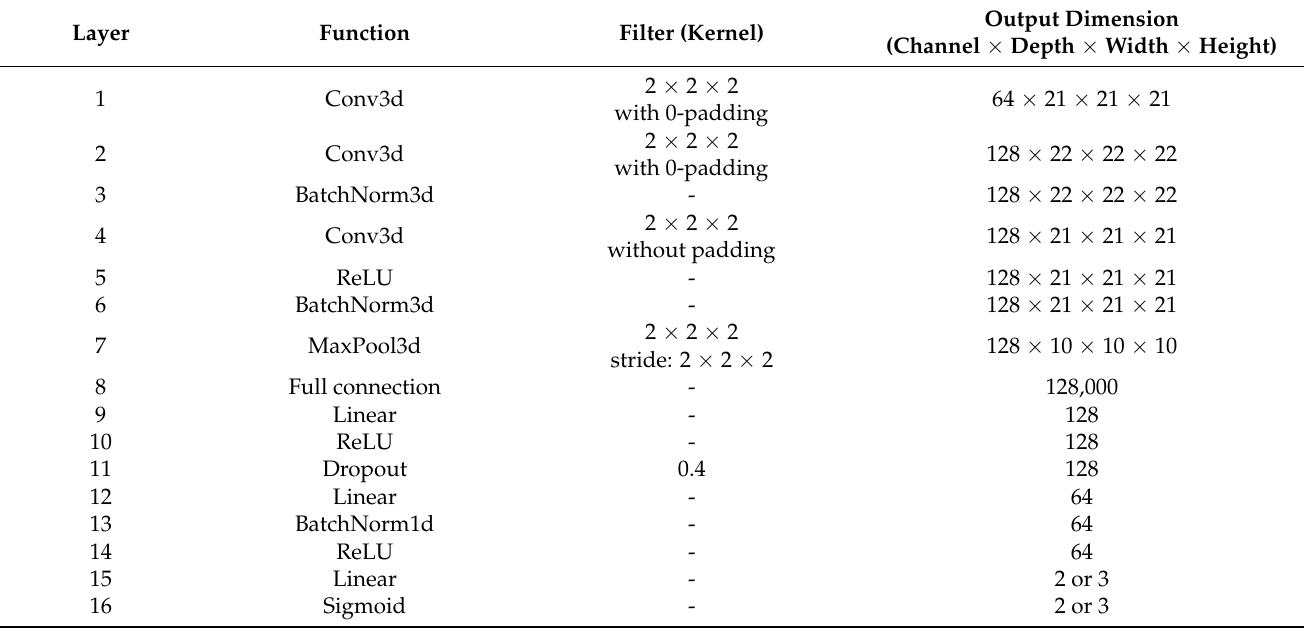
Table 1. Layers and parameters of our CNN